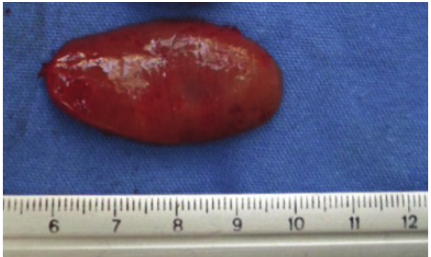
Figure 3: Ectopic parathyroid adenoma with approximately 4 cm dimension in the larger